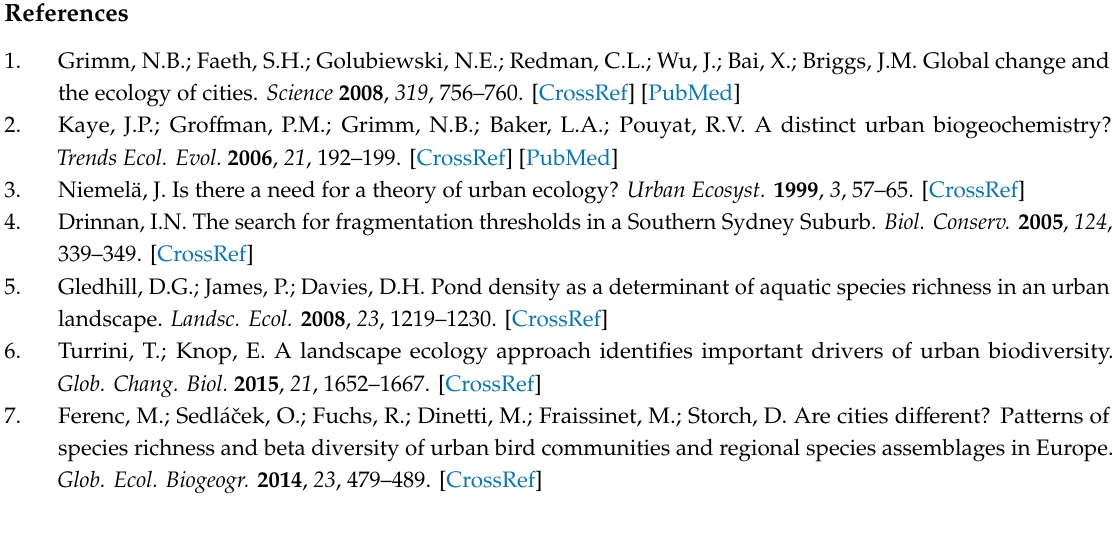
Figure S1: Maps showing the locations of the trees sampled in this study, Figure S2: Rarefaction curves showing the accumulative number of species found when increasing the number of sites (trees) sampled, Figure S3: Diagnostic plots of minimum adequate model LDV~Circumference + Species + Number trees within 10 m, Table S1: List of identified species in this study including their assigned species number by the British Lichen Society and functional trait groups, Table S2: Results of partial F-test of generalized linear model: LDV + 1 = Circumference + Species + Park + Species × Circumference + Species × Rugosity + Circumference × Rugosity + Distance to nearest tree + Distance to nearest Quercus + Number trees within 10 m, Table S3: Summary table of generalized linear model: LDV + 1 = Circumference + Species + Number trees within 10 m, Table S4: ANOVA table comparing the non-collapsed (Model 1) and collapsed (Model 2) generalized linear model, Table S5: Results of χ 2 test of generalized linear model: CWM sexual reproduction = Circumference + Species + Park + Distance to nearest tree + Table S6: Results of χ 2 test of generalized linear model: CWM acidophilous pH preference = Circumference + Species + Park + Distance to nearest tree + Distance to nearest Quercus + Number trees within 10 m + Species × Rugosity + Circumference × Rugosity, Dataset 1: Measured host tree variables, lichen species abundances, and Lichen Diversity Values (LDV) for each sampled tree, Dataset 2: Functional trait groups for all lichen species identified in this study, Computer Code: Computer code for all statistical analyses in